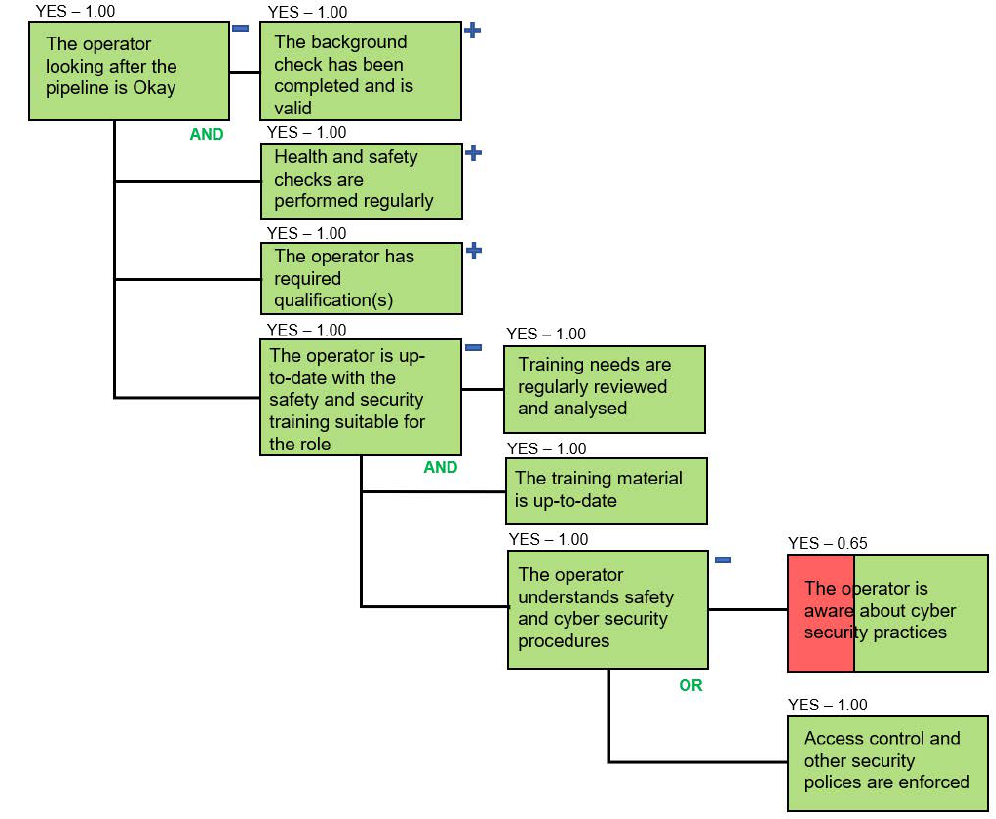
Figure 10. Access Control and Other Security Policies are introduced as